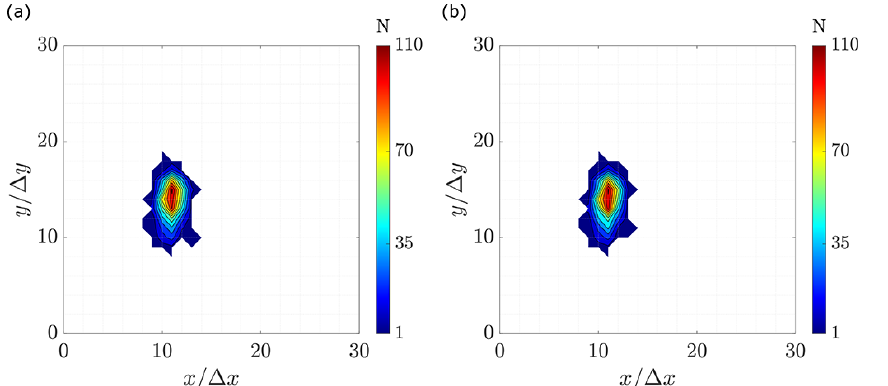
Figure A2. Graftieaux probability contours. (a) 8 points. (b) 24 points.